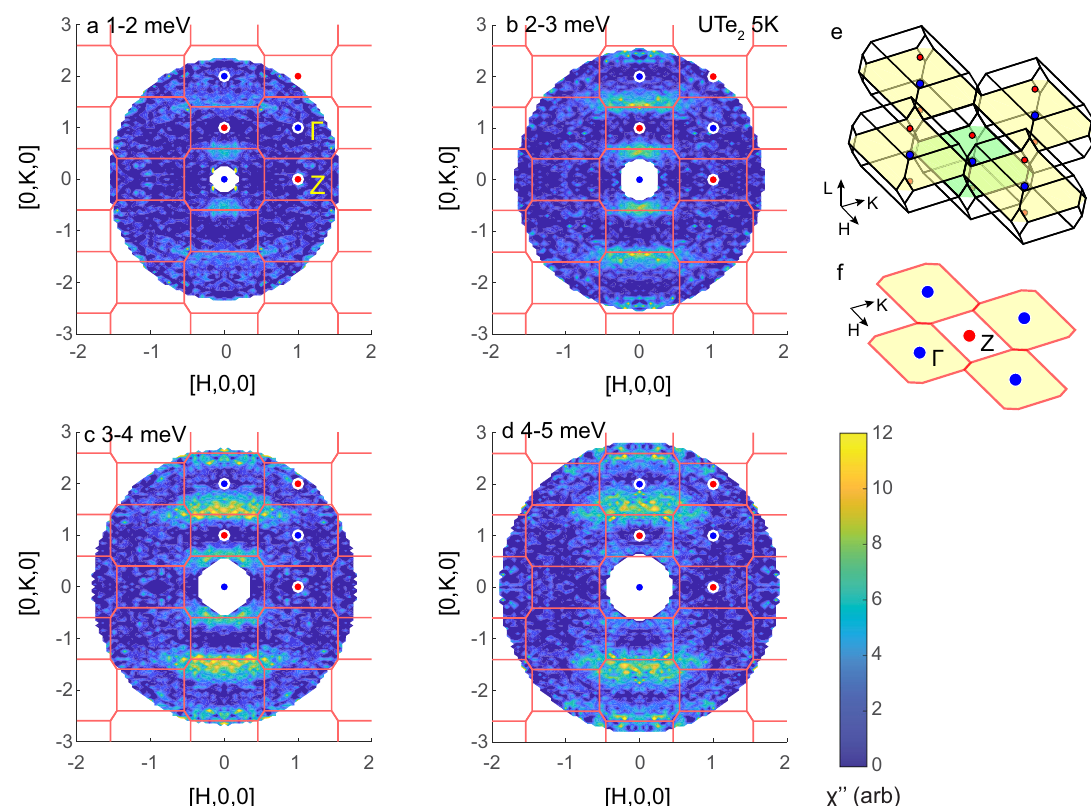
Fig. 1 Imaginary part of the dynamic magnetic susceptibility χ ″ ( Q , E ) of UTe 2 at 5 K, in the regime of strong hybridization, as measured by neutron scattering. The susceptibility in the [H, K, 0] plane, corresponding to the crystallographic ( a , b ) plane is strongest in the energy intervals ( a ) 1 – 2 meV, ( b ) 2 – 3 meV, ( c ) 3 – 4 meV, ( d ) 4 – 5 meV. These inelastic magnetic excitations closely follow the Brillouin zone edges (red) along the K direction. These excitations do not extend much beyond H = 0.5 and are absent in symmetrically equivalent Brillouin zones that are not centered on H = 0. Blue and red circles mark the Brillouin zone centers Γ and Brillouin zone faces Z , respectively, which are neighbors in the [H, K, 0] plane due to the body-centered crystal structure, shown in ( e ) three and ( f ) two